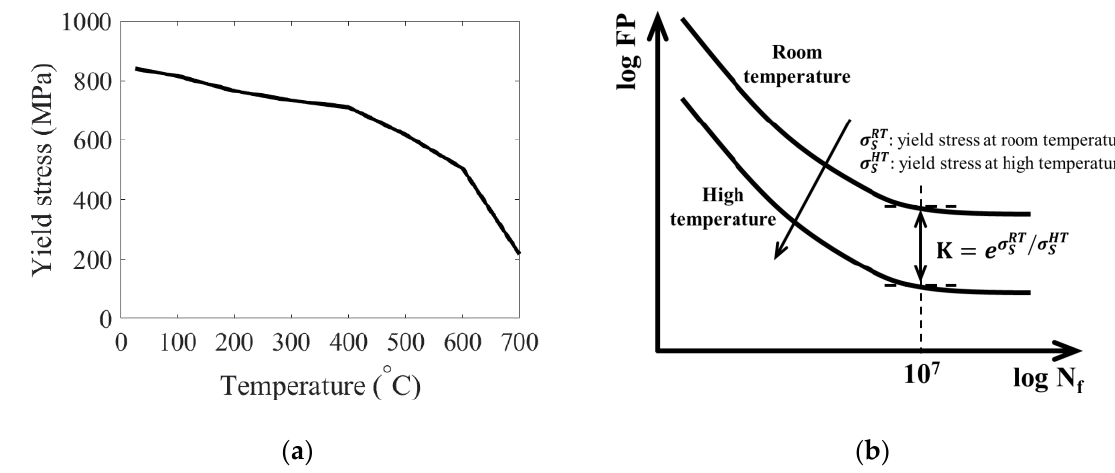
Figure 12. ( a ) The relationship between the yield stress and temperature [15], ( b ) extrapolation of fatigue curve.